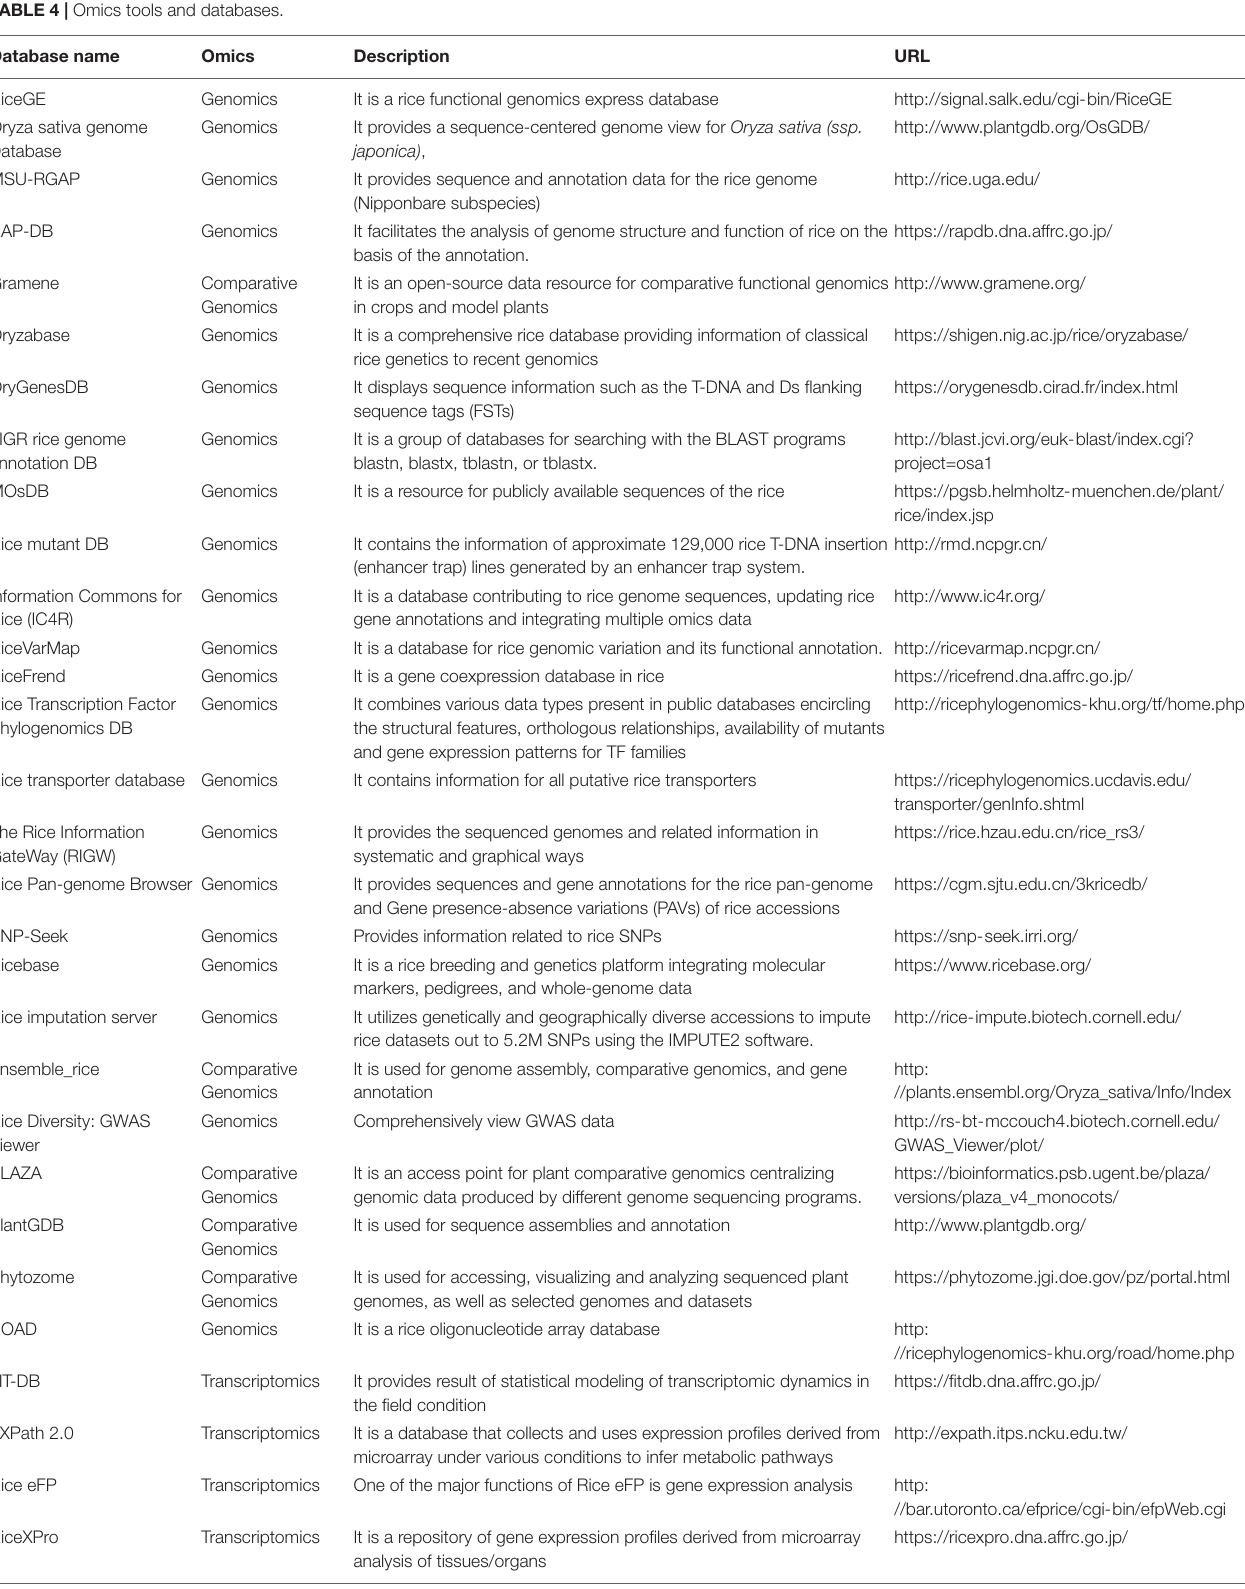
TABLE 4 | Omics tools and